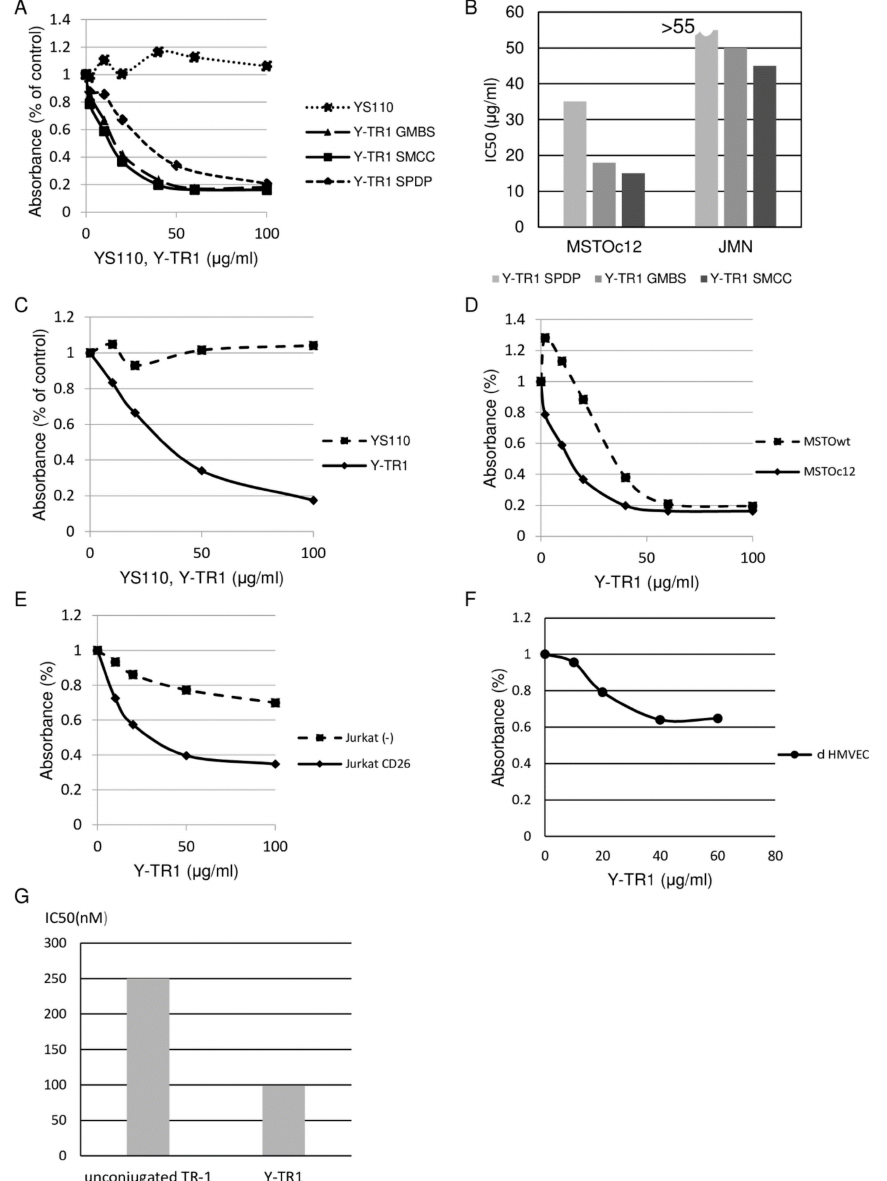
Figure 4. In vitro cytotoxicity of Y-TR1 against MM and leukemia cell lines. The representative results of at least three independent experiments are shown. ( A ) Comparison of cytotoxicity of Y-TR1 using various linkers against the CD26-positive MM cell line MSTO clone12. Y-TR1 using SMCC showed the highest cytotoxicity. The horizontal axis shows the concentration of the compounds in µ g / mL. The vertical axis shows the percent of control of the absorbance value in the WST-1 assay; ( B ) comparison of IC50 of Y-TR1 using three linkers, SPDP, GMBS, and SMCC against CD26-positive MM cell lines MSTO clone12 and JMN; ( C ) in vitro cytotoxicity of TR-1 against the CD26-positive MM cell line JMN compared to unconjugated YS110. The horizontal and vertical axes show the same as indicated in ( A ); ( D and E ) higher in vitro cytotoxicity of Y-TR1 against the CD26-positive MM cell line MSTO clone12 compared to the CD26-negative counterpart MSTO wt ( D ) and CD26-positive leukemia cell line Jurkat CD26 ( + ) compared to the CD26-negative counterpart Jurkat ( − ) ( E ) at Y-TR1 concentration of 20 µ g / mL. The vertical axis of the graph shows the percent of control in the WST-1 assay; ( F ) in vitro cytotoxicity of Y-TR1 against CD26-positive non-cancer adult dermal human microvascular endothelial cells (dHMVECs). Horizontal and vertical axes show the same as indicated in ( A ); ( G ) IC50 of unconjugated TR1 and Y-TR1 compared in molar